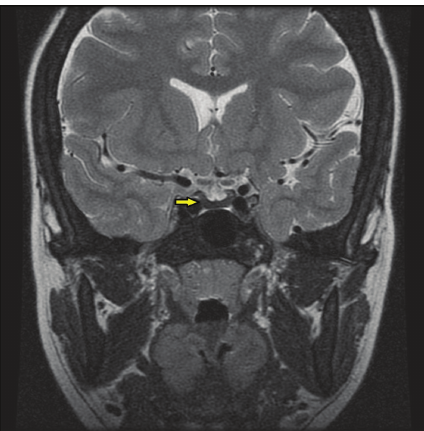
Figure 1: T2-weighted MRIshowed decreased signal intensity of the pituitary gland, compatible with iron